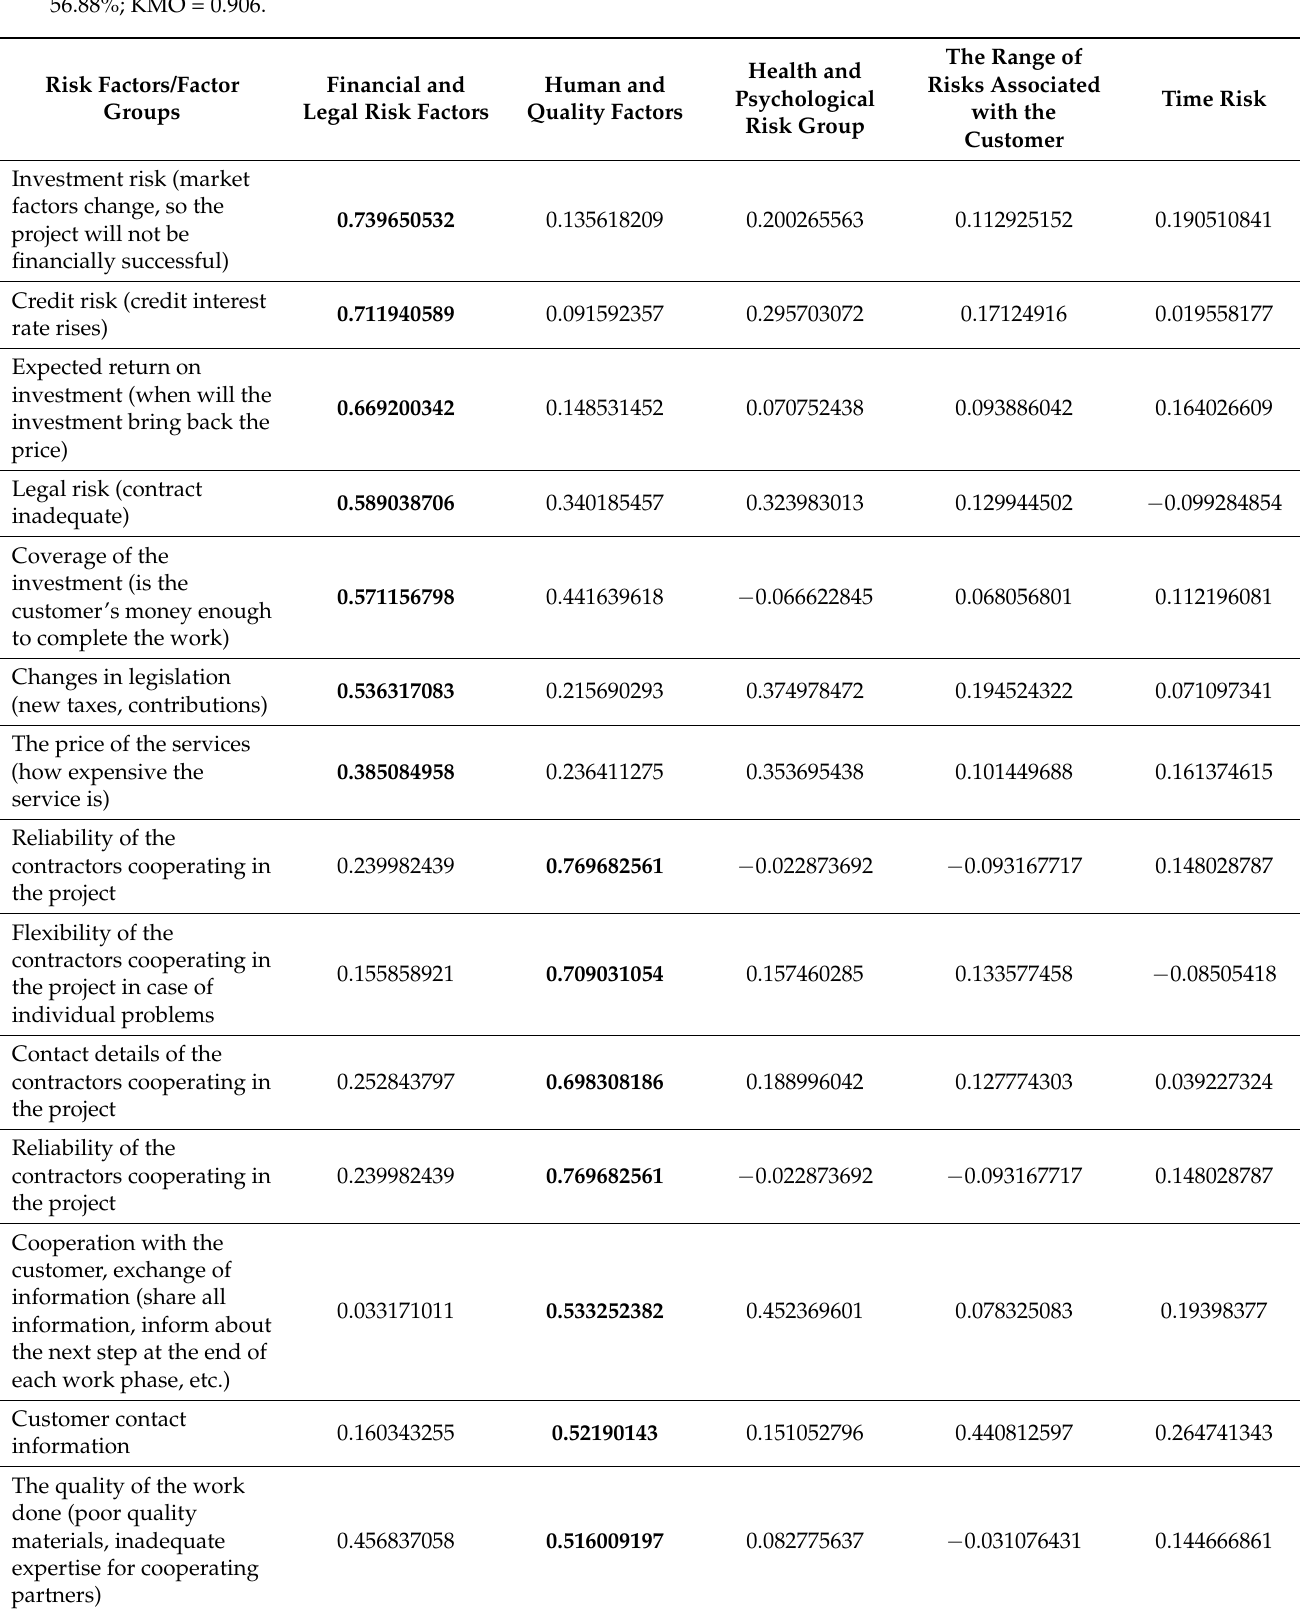
Table 6. Contractor risk factor structure for 5 factors. Source: authors’ own research, 2018. N = 462 people, total relevance = 56.88%; KMO =